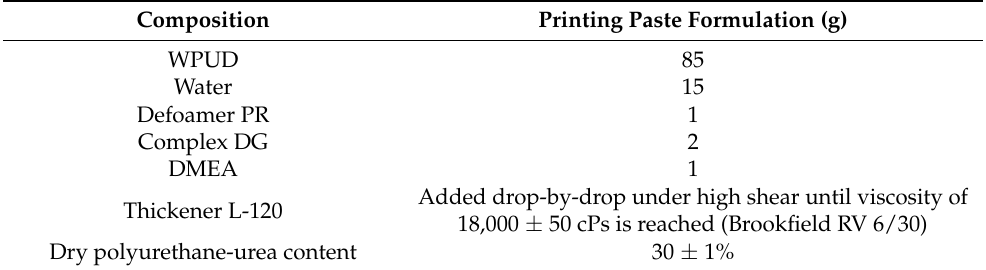
Table 2. Printing paste formulation employed to perform the coating of the fabrics with